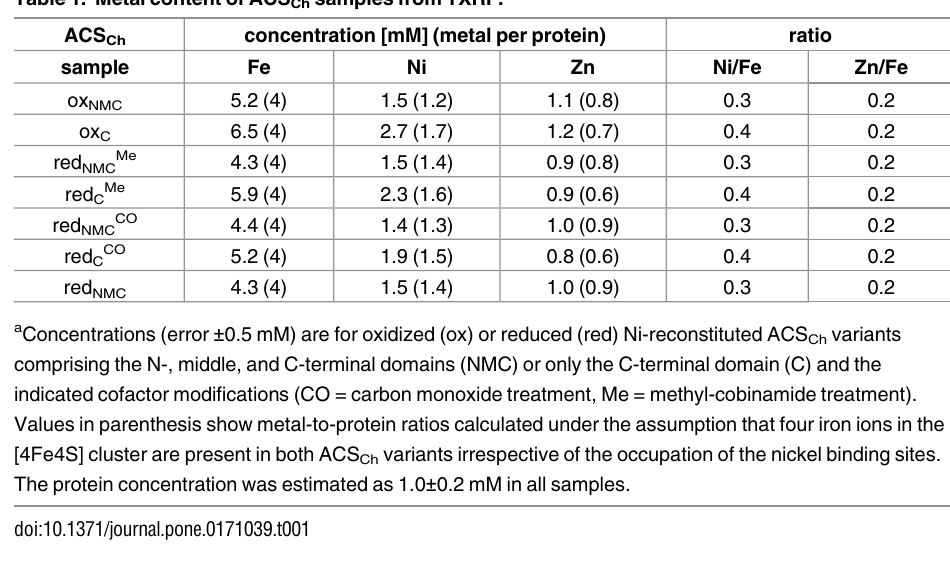
Table 1. Metal content of ACS Ch samples from TXRF. a